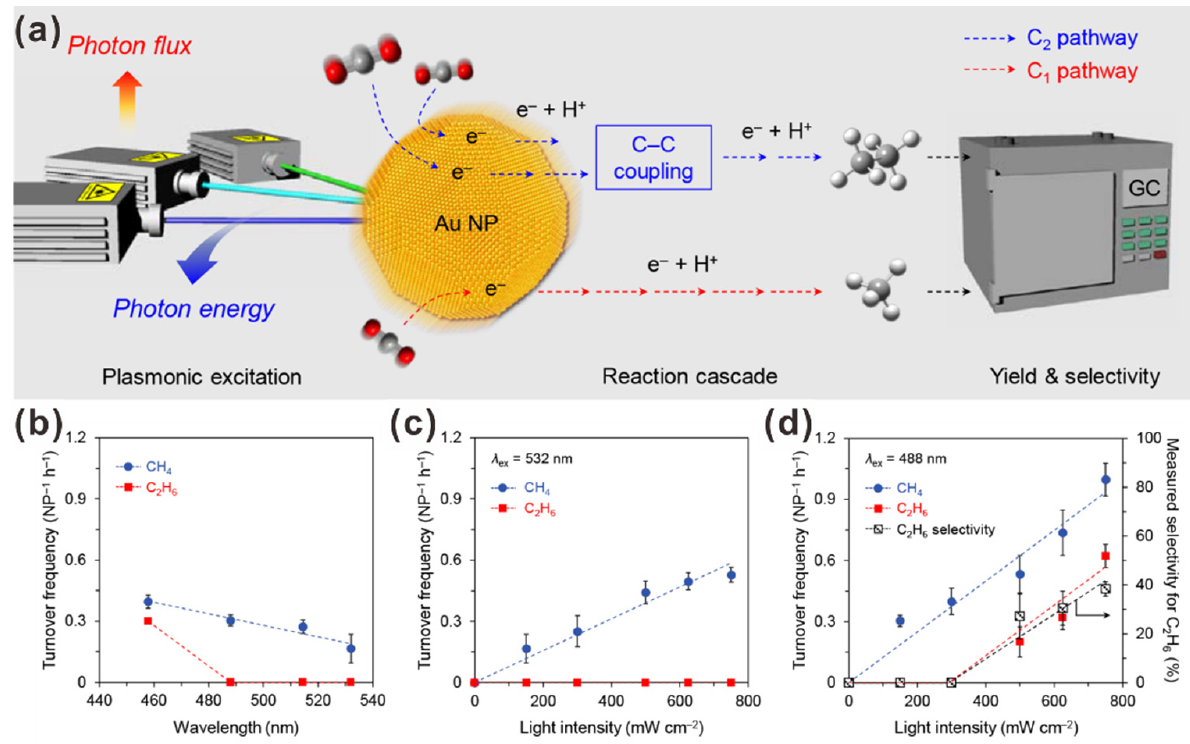
Figure 2. ( a ) The mechanism of CO 2 photoreduction into CH 4 and C 2 H 6 with AuNPs (11.8 ± 2.3 nm), and the photocatalytic efficiency under ( b ) different wavelengths and ( c , d ) light intensities. Reproduced with permission from Reference [77]. Copyright 2018 American Chemical Society.